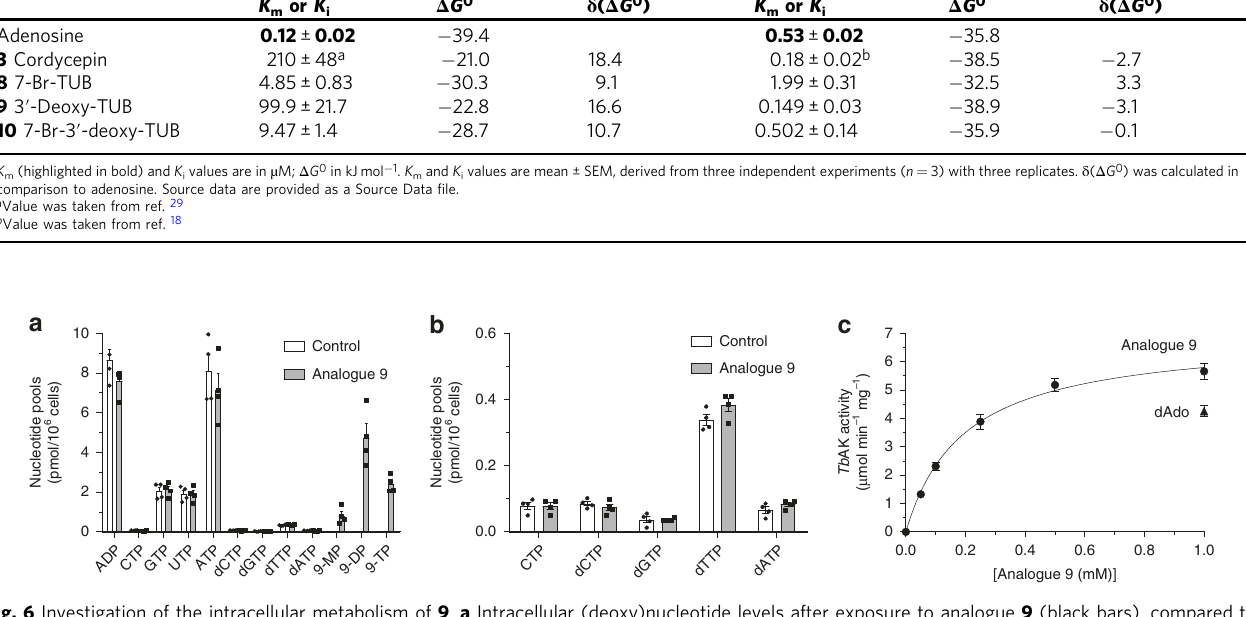
Table 3 Kinetic parameters nucleoside analogue for P1 and P2 transporters. Compound